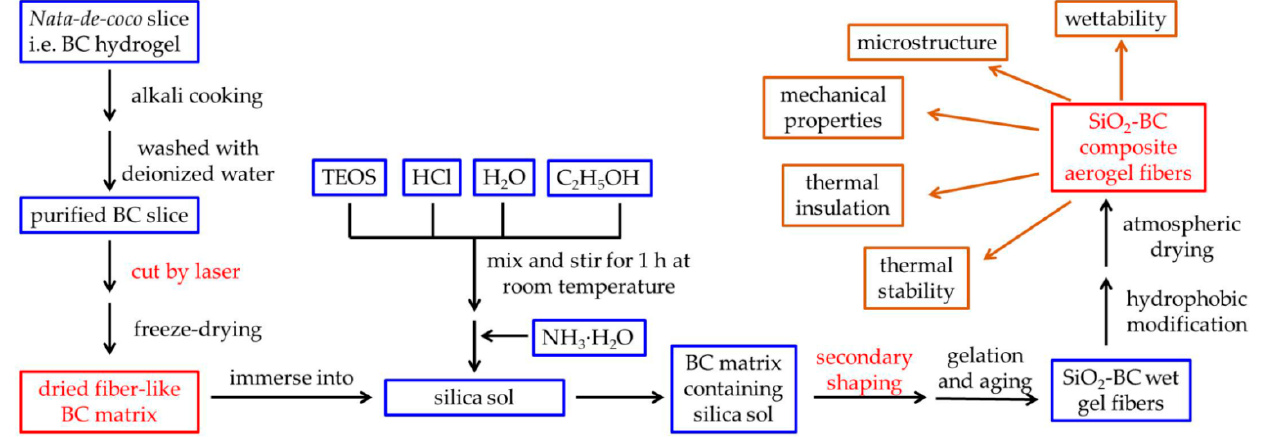
Figure 8. Flowchart illustrating the overall processes used in this work.